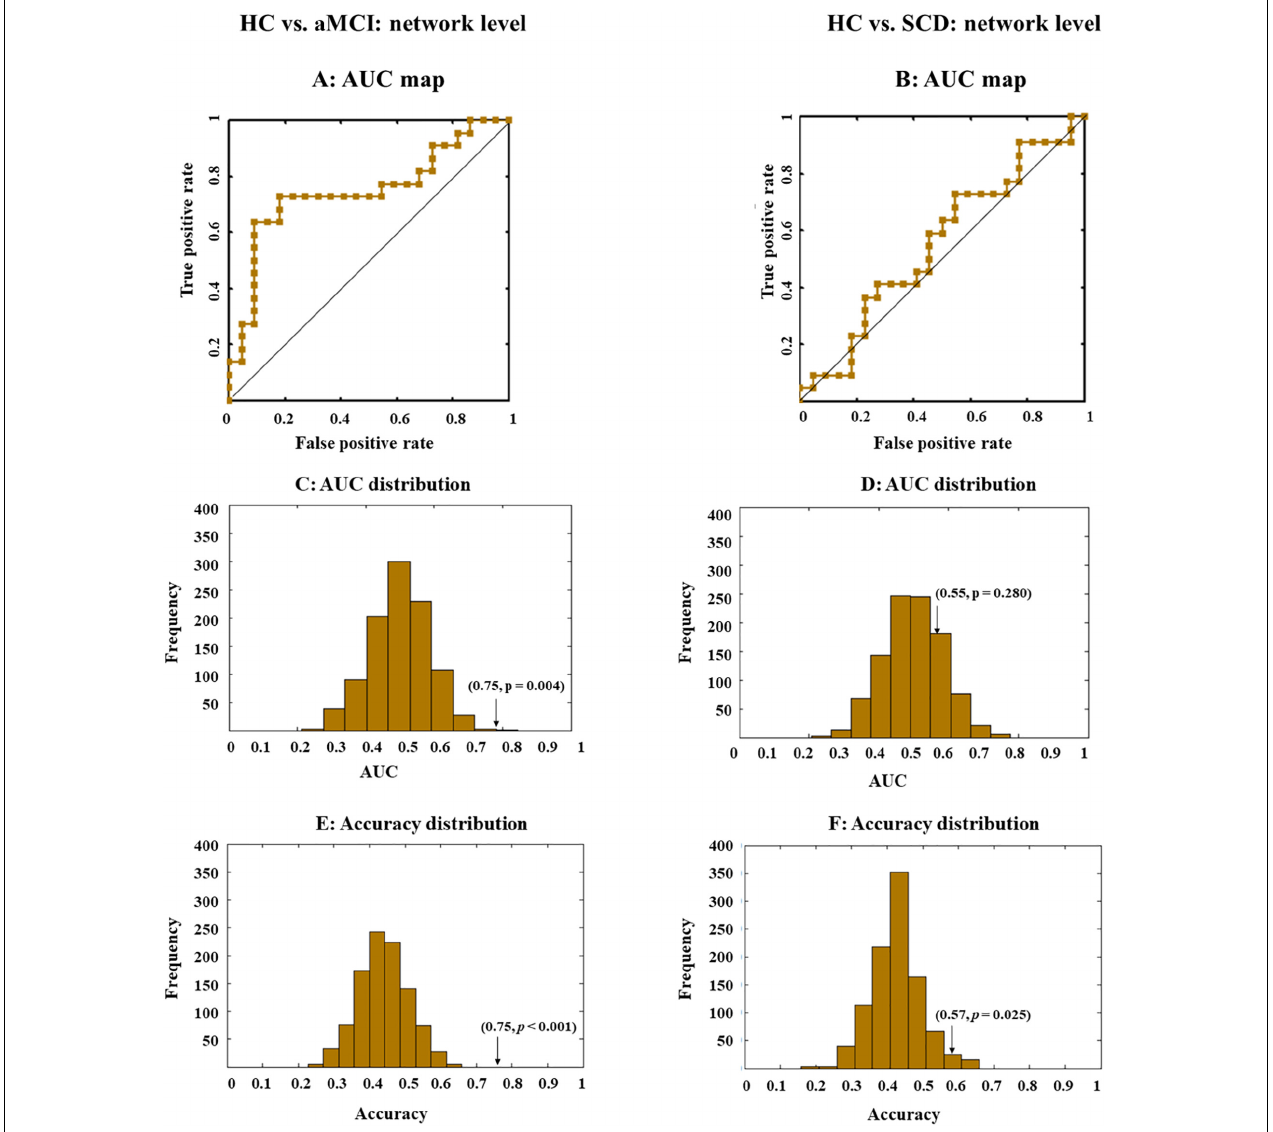
FIGURE 3 | Receiver operating characteristic (ROC) and area under the curve (AUC) or accuracy distribution when all indexes (i.e., global efficiency, local efficiency, cluster efficiency, and short path) at the network level were combined. ROC maps shows the classification performance (A,B) , where a greater AUC corresponds to better performance. AUC and accuracy distribution maps (C–F) were built by permutation tests, during which group labels were randomly arranged 1,000 times. Arrows in the distribution maps marker AUC or accuracy based on real group labels.